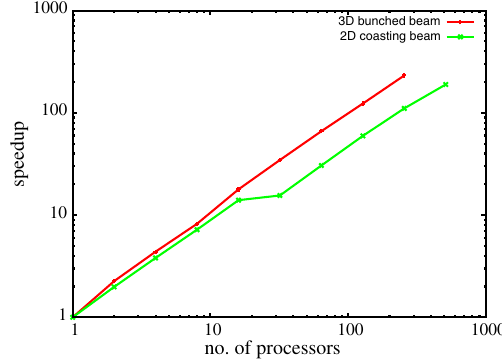
FIG. 9. Six-dimensional rms emittance growth evolution in the periodic channel from the symplectic spectral model (red) and from the PIC (green).